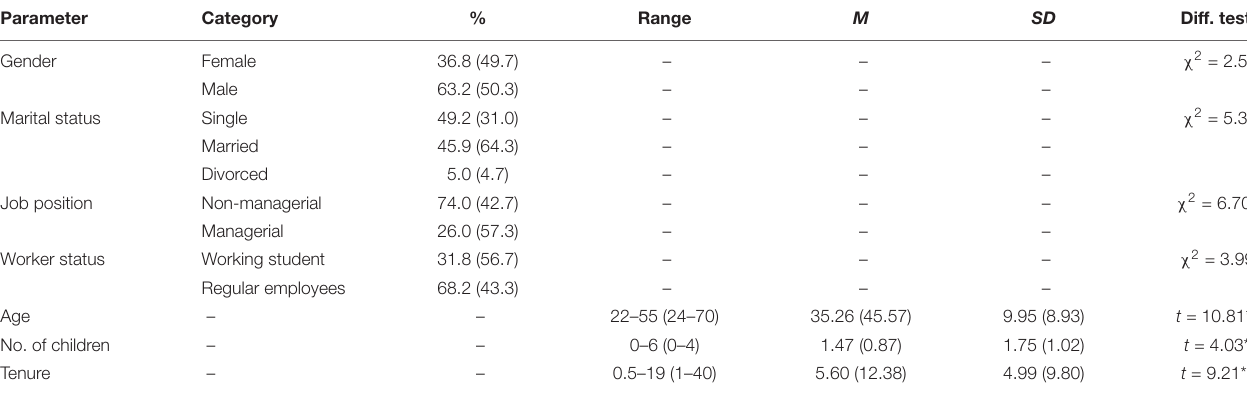
TABLE 1 | Demographical and descriptive statistics for the Israeli ( N = 242) and the Japanese ( N = 171; in parenthesis) samples. Parameter Category %